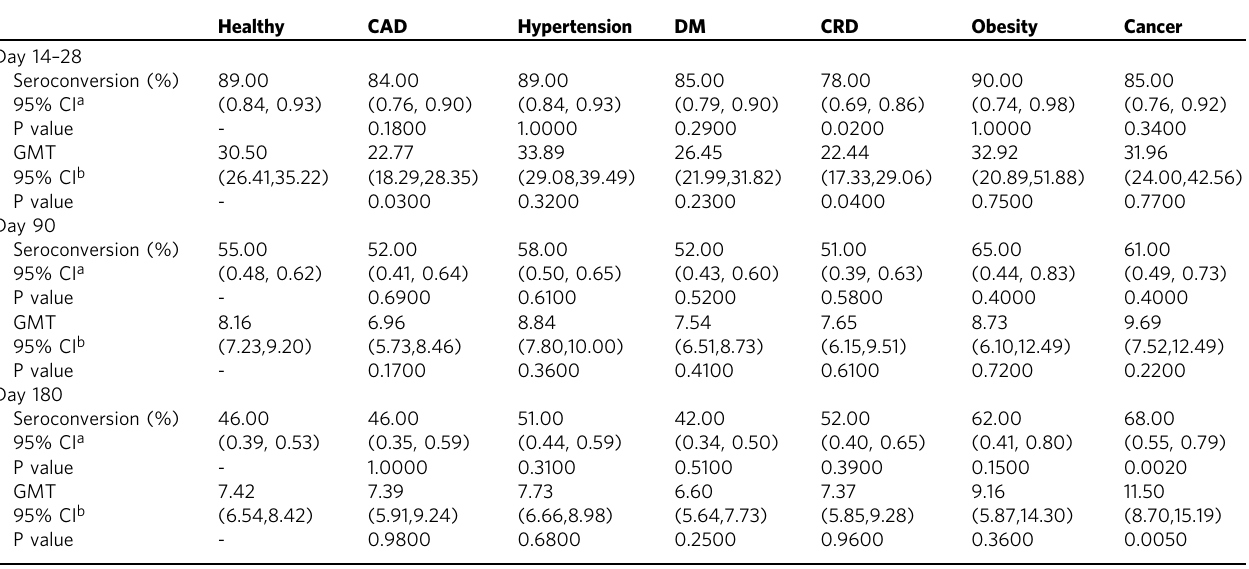
Table 3 Immunogenicity among participants with underling disease and healthy 14 – 28 days, 3 months, and 6 months after two-dose